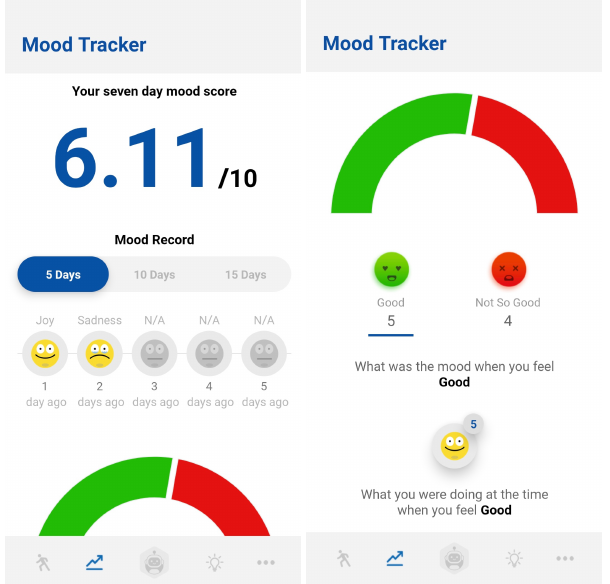
Figure 5. Temporal mood score and mood calendar enabling remote mental health monitoring. ∑ mood scores for the last 7 days 7-day average rolling mood score = number of mood scores for last 7